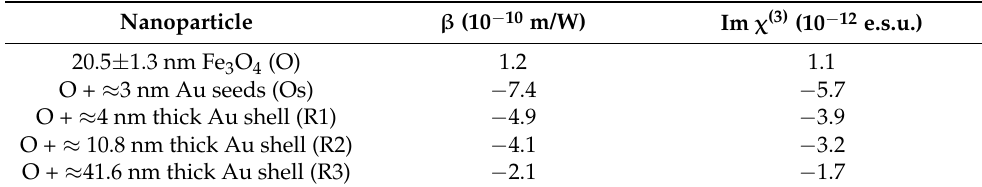
Table 2. Various magnetic-plasmonic nanostructures and their associated nonlinear absorption parameters — β is the nonlinear absorption coefficient and Im χ (3) is the imaginary part of the third- order susceptibility.